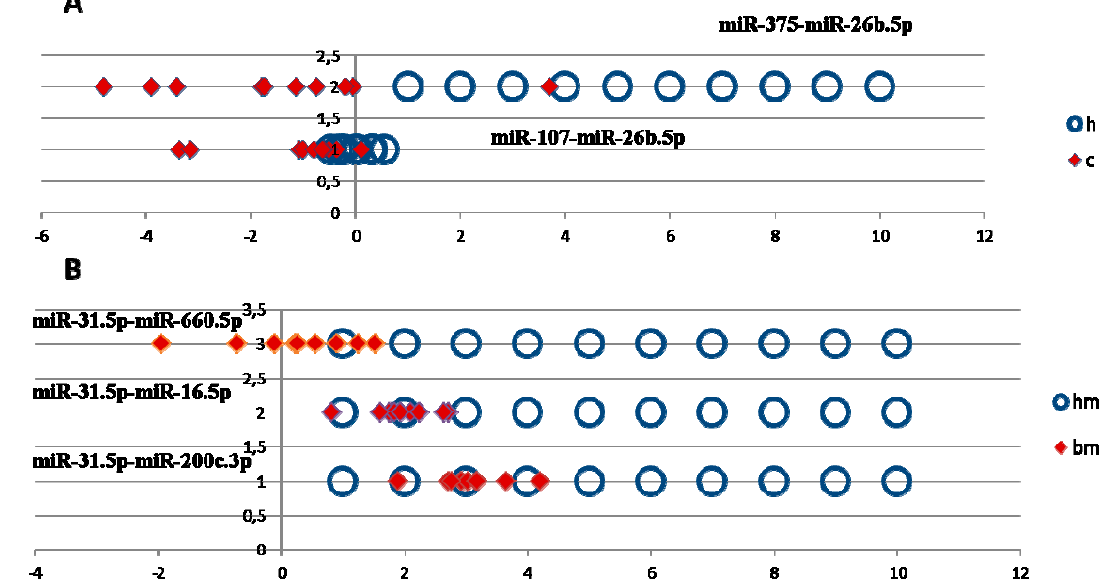
Figure 1. ( A ) Distribution of normalized d C t values for miR-375.3p-miR-26b.5p and miR-107-miR-26b.5p pairs in healthy donors and PCa patients. ( B ) Distribution of normalized values of healthy donors and patients with BPH, miR-31.5p-miR-660.5p, miR-31.5p-miR-16.5p and miR-31.5p-miR-200c.